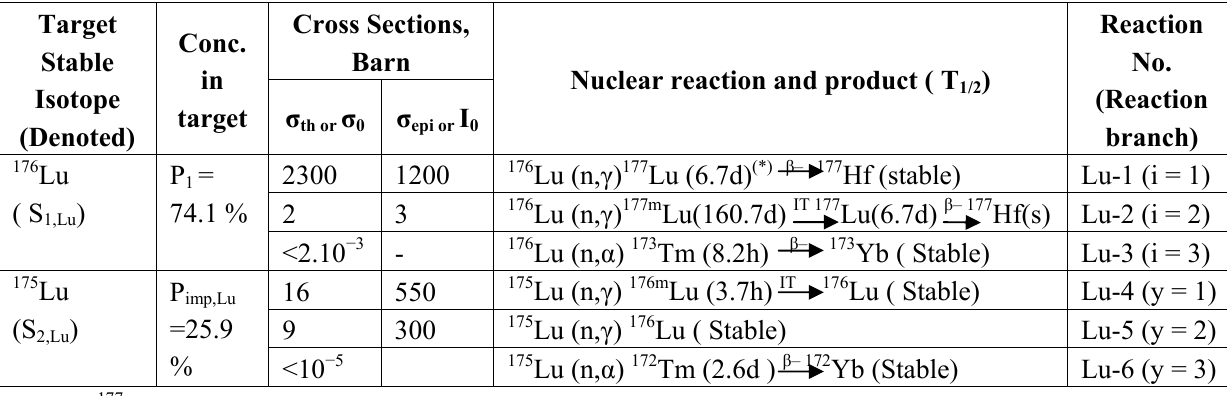
Table 1. Nuclear characteristics of the radionuclides produced in the 176 Lu enriched target